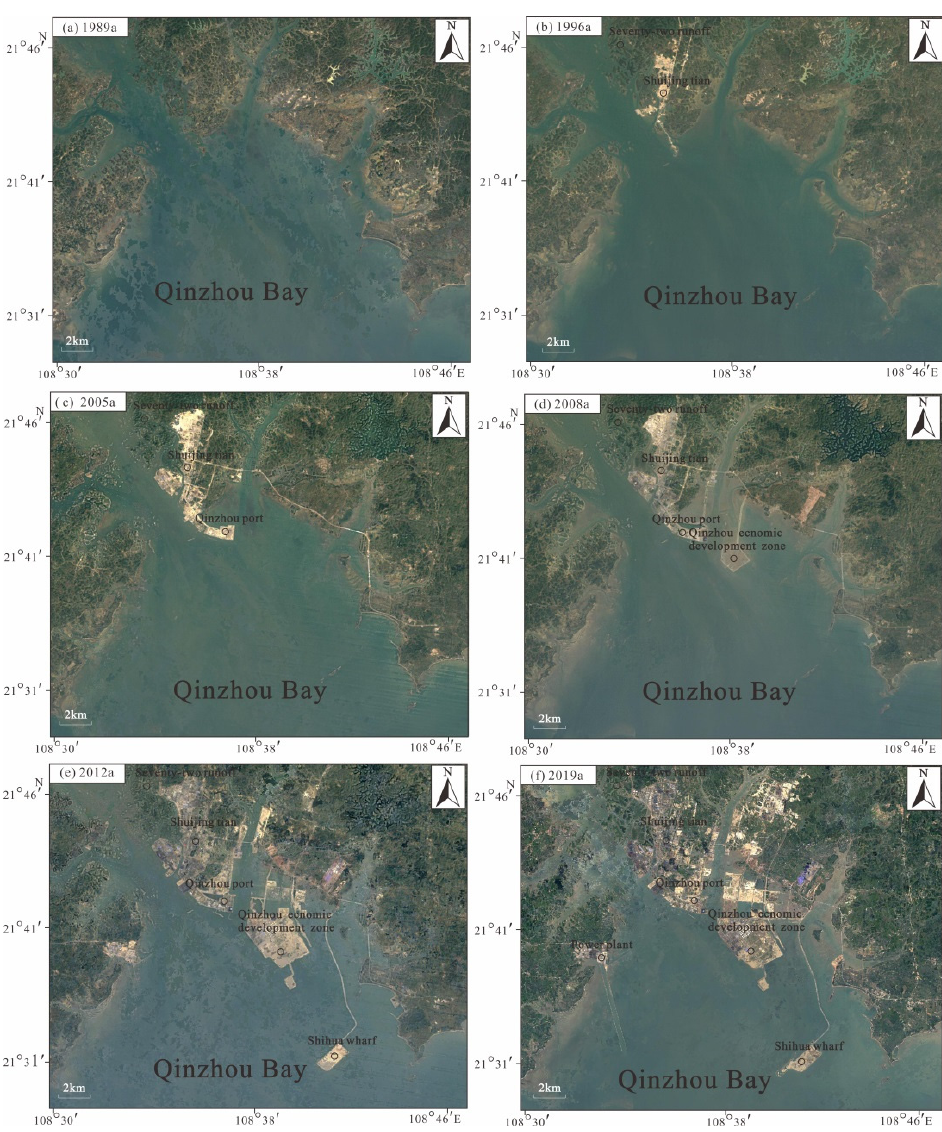
Figure 9. Multi-phase images of sea reclamation in outer Qinzhou Bay in a recent 30-year interval.